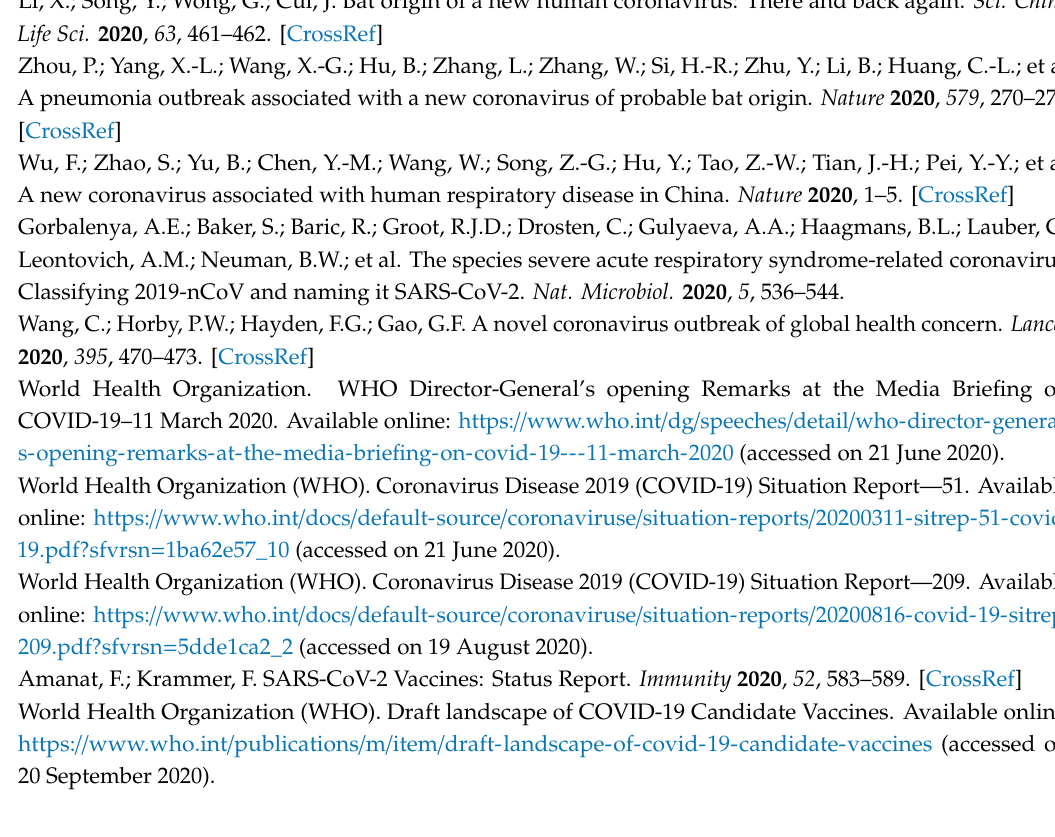
Section C: The E ff ective Reproduction Number R t ; Section D: Result Figures (Figure S6. Estimation of transmission rate: Incidence of each age groups. Incidences by local transmission (local and imported transmission) are blue-colored (red-colored); Figure S7. Estimation of transmission rate: Cumulative Incidence of each age groups. Incidences by local transmission (local and imported transmission) are blue-colored (red-colored); Figure S8. Scenario simulation: (a) Incidence and (b) Cumulative Incidence of all ages. s, m, w denote strong, medium, weak social distancing, respectively, and w + denotes weak social distancing + . Black circles are actual incidence data; Figure S9. Scenario simulation: Incidence of each age groups; Figure S10. Scenario simulation: Cumulative Incidence of each age groups; Figure S11. Other figures. (a) is scenario specific analysis on 31 Aug. 2020., (b) is 20–49 and (c) is 50 or older age group. s is strong-, m is medium-, w is weak- and w + is weak social distancing + ; Figure S12. Monthly incidence of two age groups of 20–49 and 50 or older (50 + ) for the baseline, scenario 1 and 7 on di ff erent types c O levels for strong, medium and weak social distancing: (a) c O = 0.3, 0.6, 0.9, (b) c O = 0.3, 0.6, 0.9, (c) c O = 0.2, 0.5, 0.8, (d); Figure S13. Monthly incidence of two age groups of 20-49 and 50 or older (50 + ) on di ff erent three types c O levels for strong, medium and weak social distancing: (a),(b) c O = 0.3, 0.6, 0.9, (c),(d) c O = 0.2, 0.5, 0.8, (e),(f) c O = 0.3, 0.5,